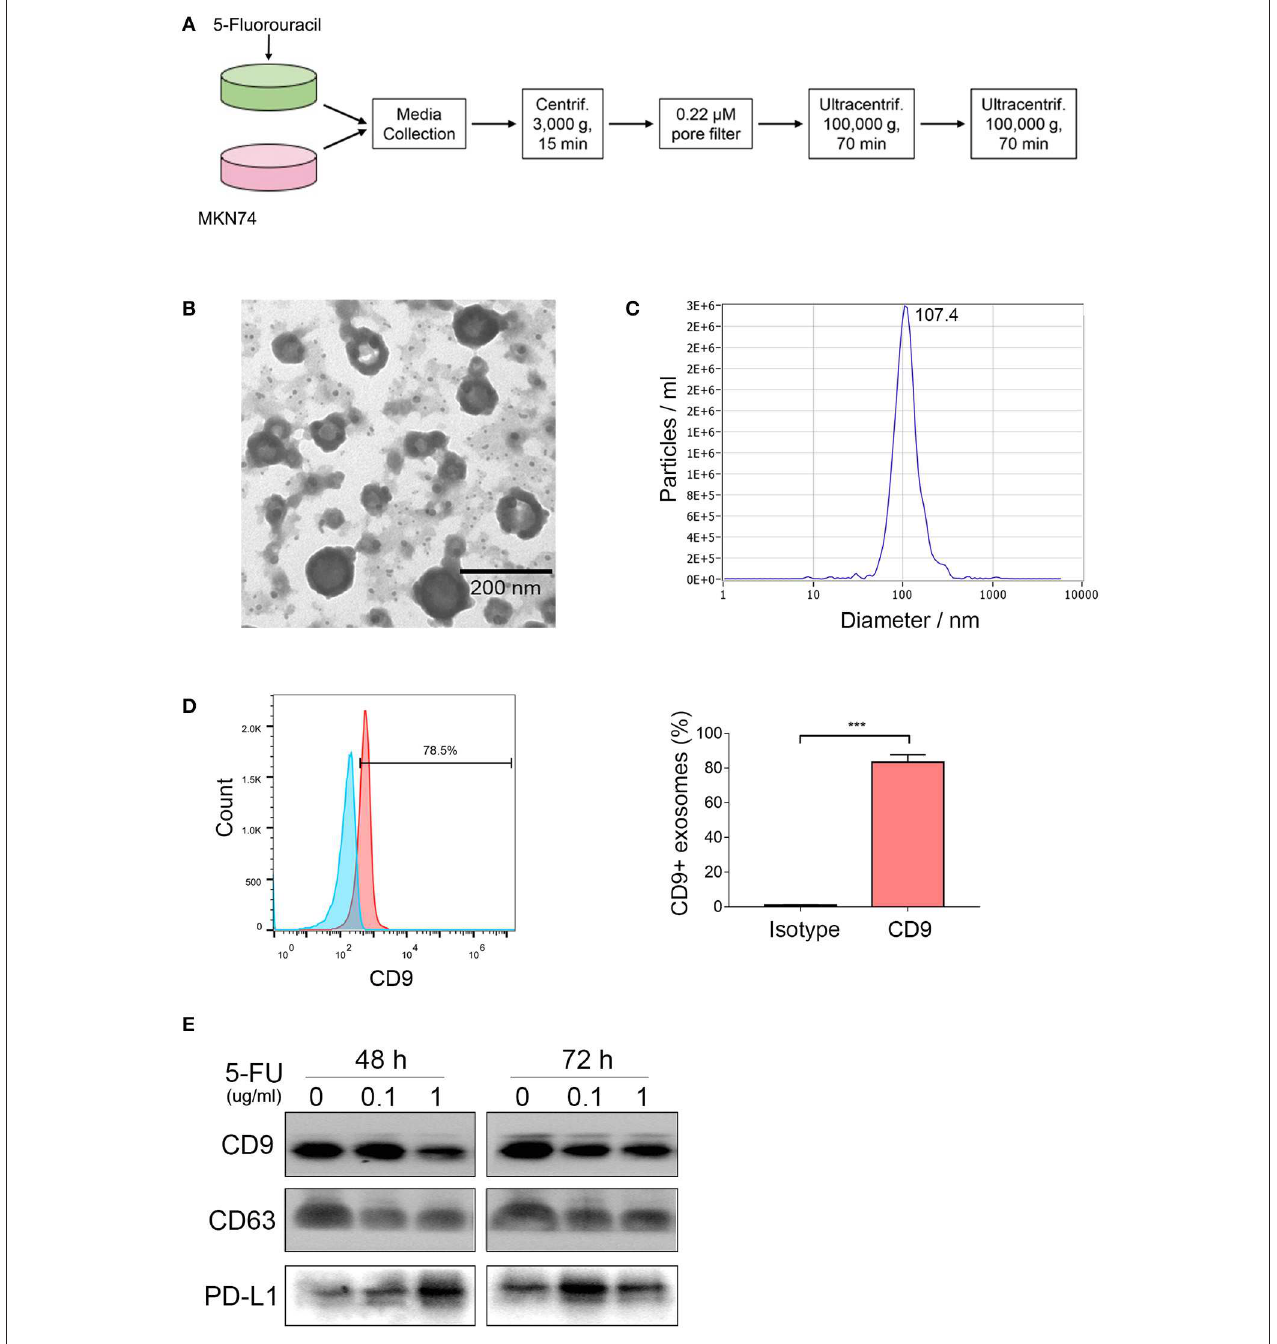
FIGURE 2 | 5-Fluorouracil (5-FU) increases the secretion of exosomal programmed death-ligand 1 (PD-L1). MKN74 cells were incubated with 5-FU (0, 0.1, 1.0 µ g/ml) for 48 and 72h, respectively. (A) Schematic illustration of MKN74 cell-derived exosomes isolation and purification from the supernatants by ultracentrifugation. (B) MKN74-derived exosomes were validated by transmission electron microscopy (TEM). Scale bar: 200nm. (C) Size distribution of exosomes was analyzed by Nanosight. (D) CD9 levels on the surface of exosomes were detected by flow cytometry analysis. Data represent mean ± SD, and Student’s t -test was used to evaluate the statistical significance (*** P < 0.001). (E) Western blot analysis of exosomes biomarker CD9 and CD63, and exosomal PD-L1 amounts. Equal amounts of proteins obtained from exosomes were immunoblotted with anti-CD9, anti-CD63, and anti-PD-L1 antibodies.